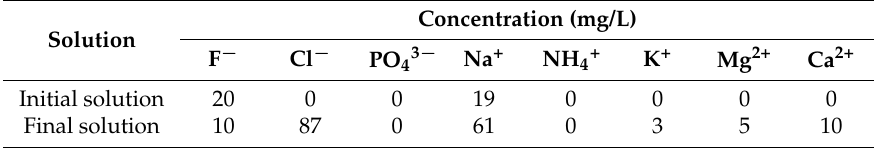
Table 4. Anion and cation concentrations of solution used for the experiment.